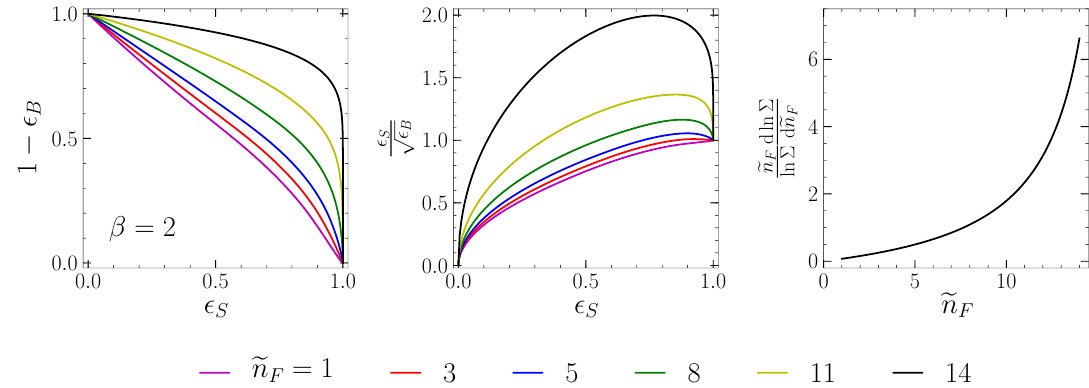
Figure 8 . Discrimination of dark sector against QCD for various choices of the number of dark quark flavors n F for p T = 1 TeV jets, using the MLL analytic calculation. Note that the impact of e errors is ignored here, see section 2.4 for details. We show ROC curves in the background rejection 1 (cid:15) B versus signal efficiency (cid:15) S plane [left]. We show the curve of discriminatory significance (cid:0) (cid:15) S = p (cid:15) B against signal efficiency (cid:15) S [middle]. Fixing the background rejection at 90 % , we then show the relative change in discriminatory power as a function of parameter is (cid:12) = 2 for all